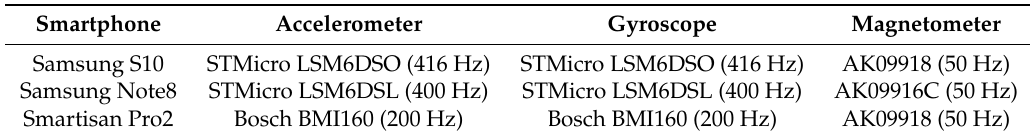
Table 2. Sensors specifications with the max. sampling